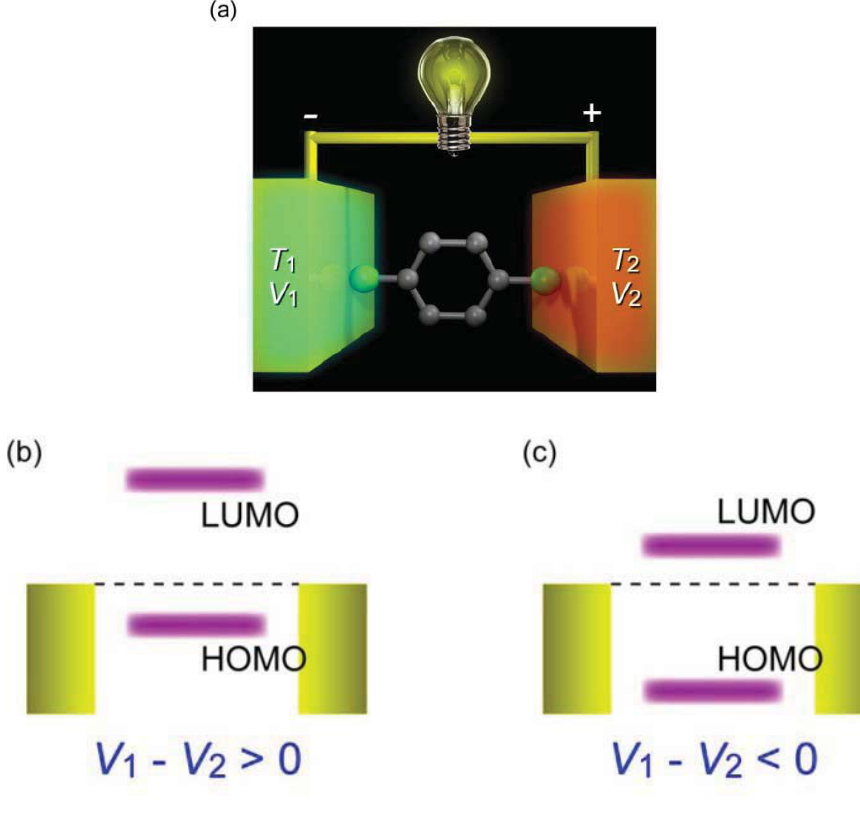
Figure 11. Thermopower measurements of Au/benzenedithiol/Au junctions. In experiments, molecular junctions were formed repeatedly by moving the tip in and out of contact with the self-assembled monolayer on the Au substrate. The substrate was heated to T the ambient T up to several tens of Kelvins. Current was measured during tip approach 1 processes using the current amplifier until the conductance reached at the set point. Subsequently, the circuit is switched and the voltage was measured using the voltage amplifier while stretching the molecular junction. ( a ) The thermoelectric voltage (cid:5) V = V could be measured during molecular junction stretching processes under the tip-substrate temperature difference (cid:5) T = T (cid:4) T . This indicates thermoelectric energy conversion by the 2 1 molecules connected to two electrodes. The junction thermopower can be deduced by measuring (cid:5) V /(cid:5) T ; ( b , c ) The sign of the thermoelectric voltage can be used as a diagnostic tool for elucidating the Fermi alignment of the metal-molecule-metal junctions: HOMO (LUMO) is closer to the electrode Fermi level when the thermoelectric voltage V positive